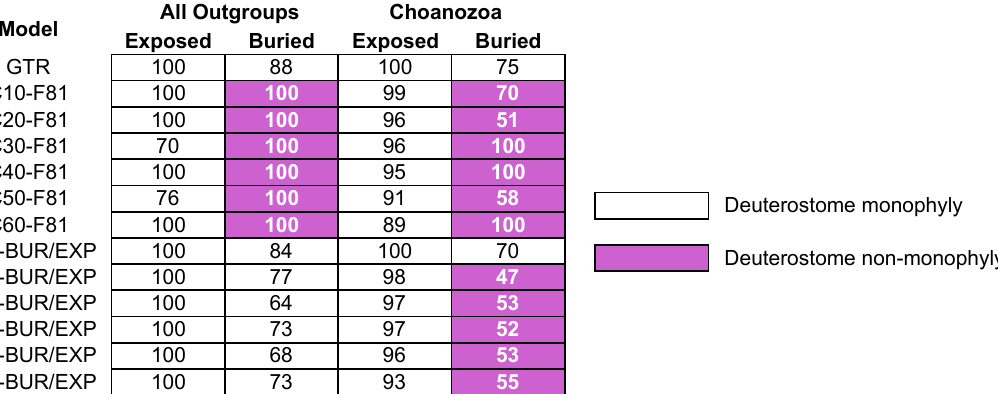
Figure 5. Heat map showing support for deuterostome monophyly for exposed and buried residues using GTR, LGL-F81, and LGL-BUR/EXP models. Colors indicate whether or not deuterostome were monophyly (No color: monophyletic, Purple: not monophyletic). Note that the bootstrap consensus tree for the LGL-BUR-C20 conflicted with the optimal tree; it had 53% support for monophyly.